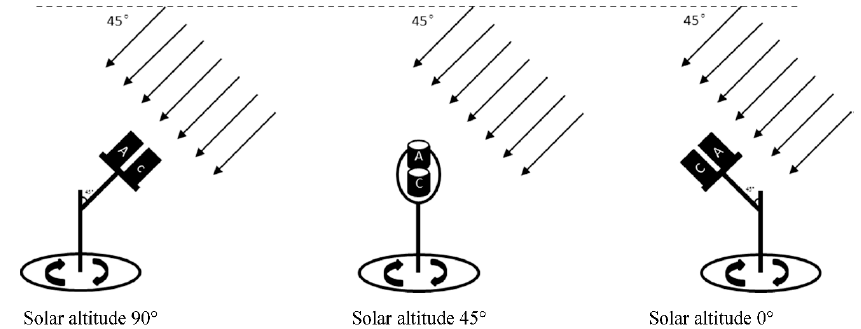
Figure 10. Calibration principle of the upward optical sensor. A and C represent the ASD spectrometer and the upward optical sensor, respectively.